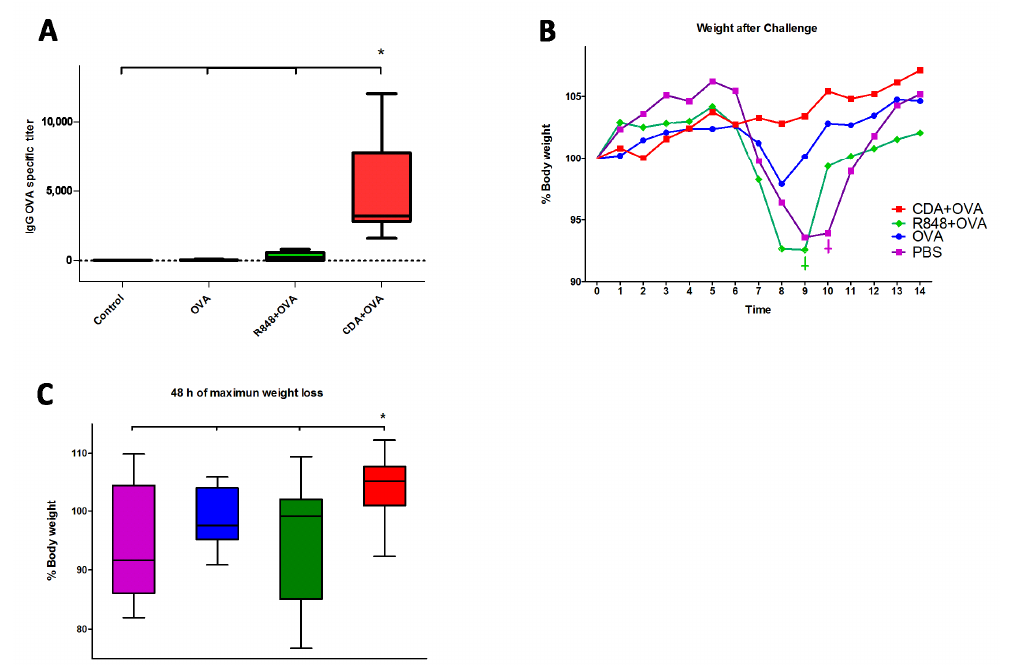
Figure 4. Neonatal vaccination with CDA confers protection in adult mice. Mice intranasally vaccinated with CDA + OVA, R848 + OVA, OVA, or PBS (control) were challenged by 10 5 PFU of the H1N1 PR8 influenza A/WSN/33 (WSN)-OVA(I) virus, which expresses the SIINFEKL peptide in the hemagglutinin domain. ( A ) Antigen-specific IgG from blood serum was measured by ELISA from blood sampled previous to challenge. Mice Vaccinated with CDA + OVA as neonates displayed significantly higher titers than animals receiving the other vaccine formulations. ( B ) Weight loss was recorded 14 days after infection as an inverse correlation of protection, where dead animals were found only in the PBS and the R848 groups (inverted crosses in plot B). ( C ) The differences between groups on the 48 h of maximum weight loss were significant between CDA + OVA vaccinated animals and the other treatments. In ( A , C ) differences are significant (*) by a non-paired Student’s t -test (* p ≤ 0.05) performed against each other treatment/control. Results shown are average from five (PBS and OVA controls) and six (CDA and R848 treatments) mice per group, from one representative out of two experiments.